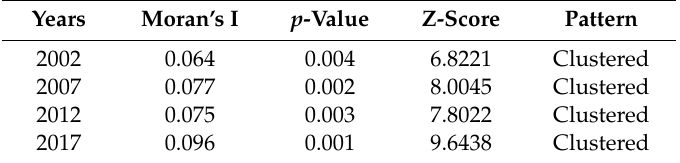
Table 1. Global Moran’s I and population density pattern for the period ranging from 2002 to 2017. Years p -Value